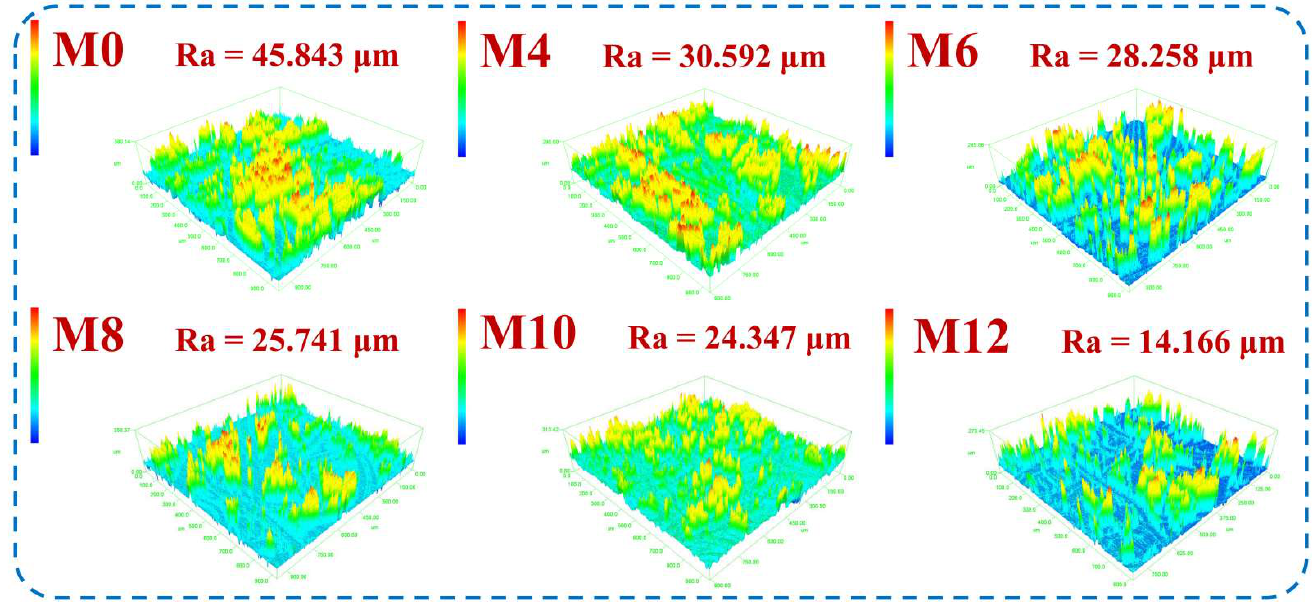
Figure 8. The 3D surface roughness of ZIF-8/PPS fiber membranes (M0: untreated; M4: 4 h; M8: 8 h; M10: 10 h; M12: 12 h).